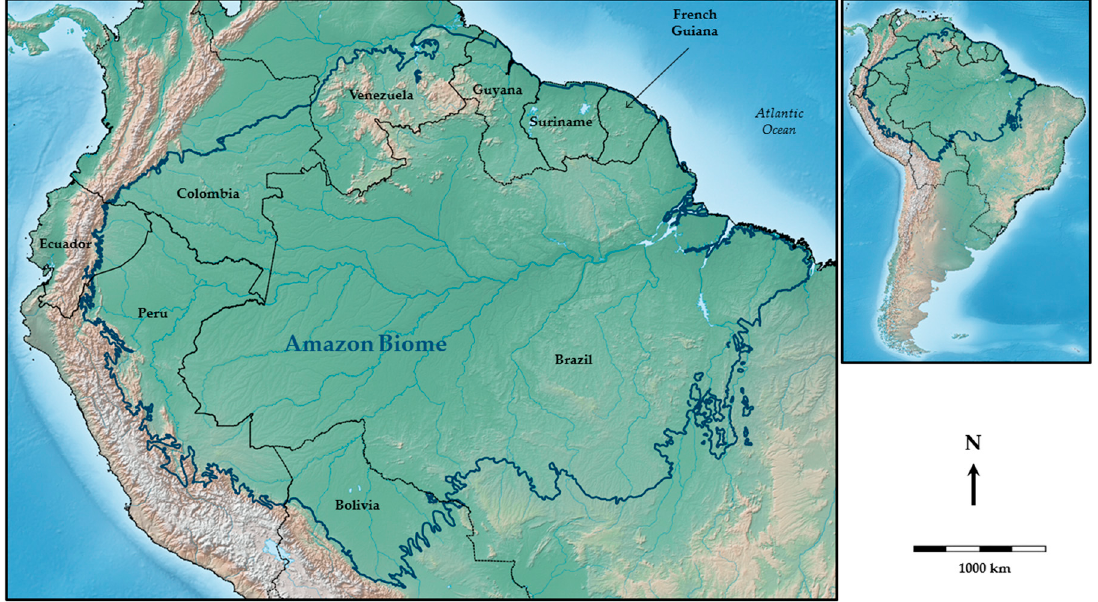
Figure 1. Geographical context of the study area in the Amazon region (the background is made with Natural Earth. Free vector and raster map data @ naturalearthdata.com, and the limits of the Amazon biome were obtained from the World Terrestrial Ecoregions map of the Nature Conservancy [38]). The Amazon Basin has the most extensive and diverse freshwater wetlands in the world.